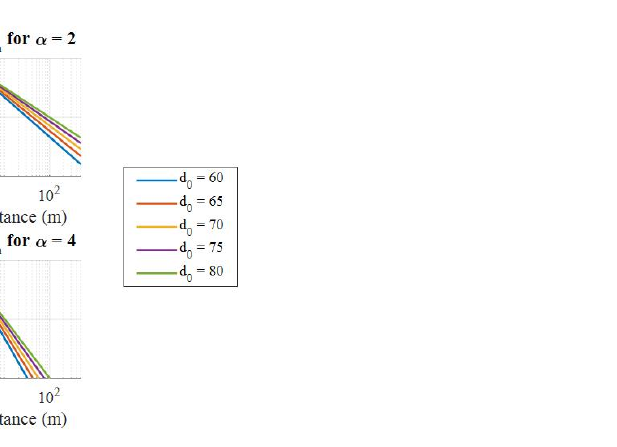
Figure 10. Probability of successful communication for different values of alpha and d 0 as function of distance between two autonomous underwater vehicles (AUVs).